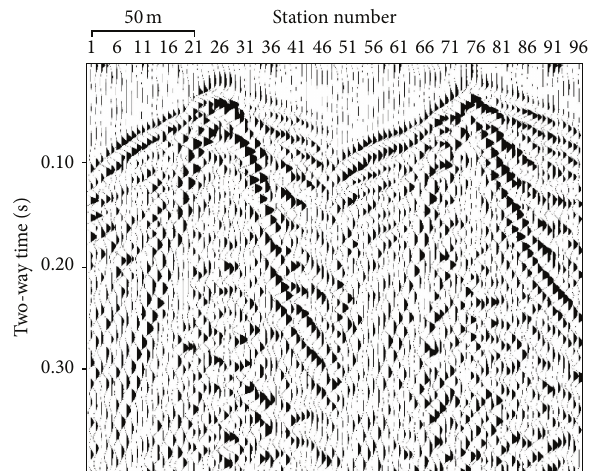
Figure 7: Typical common shot gathering including 96